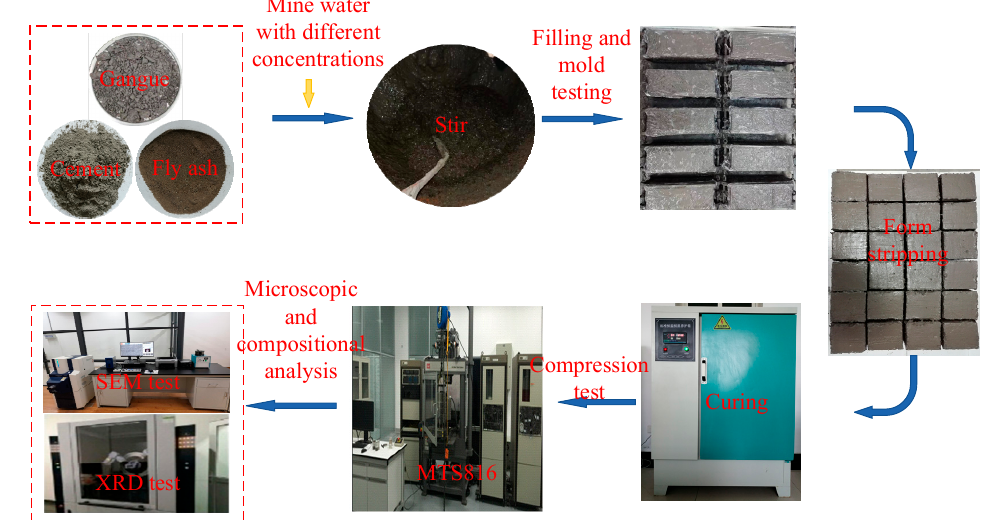
Figure 2. Flow chart of the experiment.